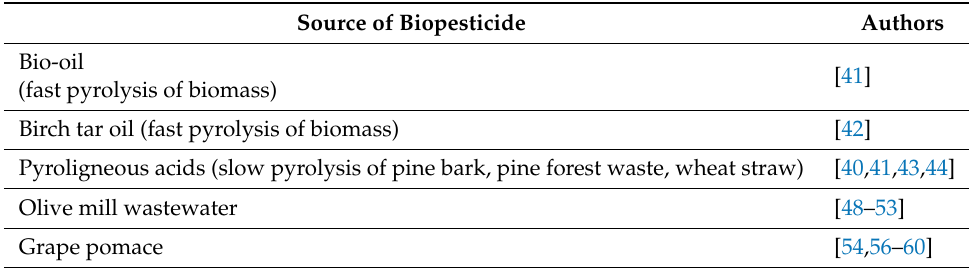
Table 2. Organic waste as a source of biopesticide